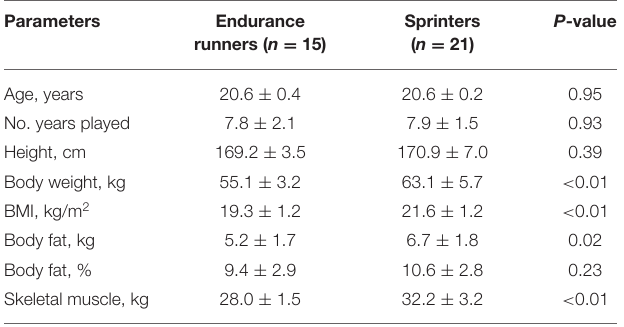
TABLE 2 | Comparison anemia related parameters between endurance runners and sprinters.